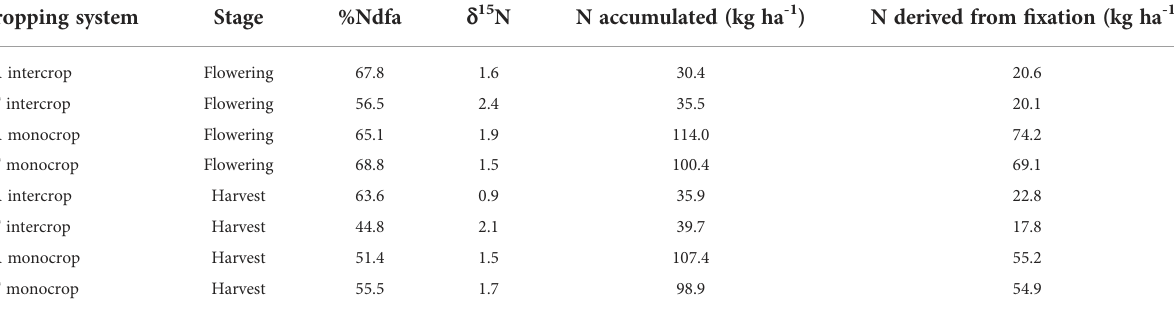
TABLE 4 %Ndfa, d 15 N, N accumulated (kg ha ‐ 1 ) and N derived from fi xation (kg ha ‐ 1 ) for cowpea plants under various cropping